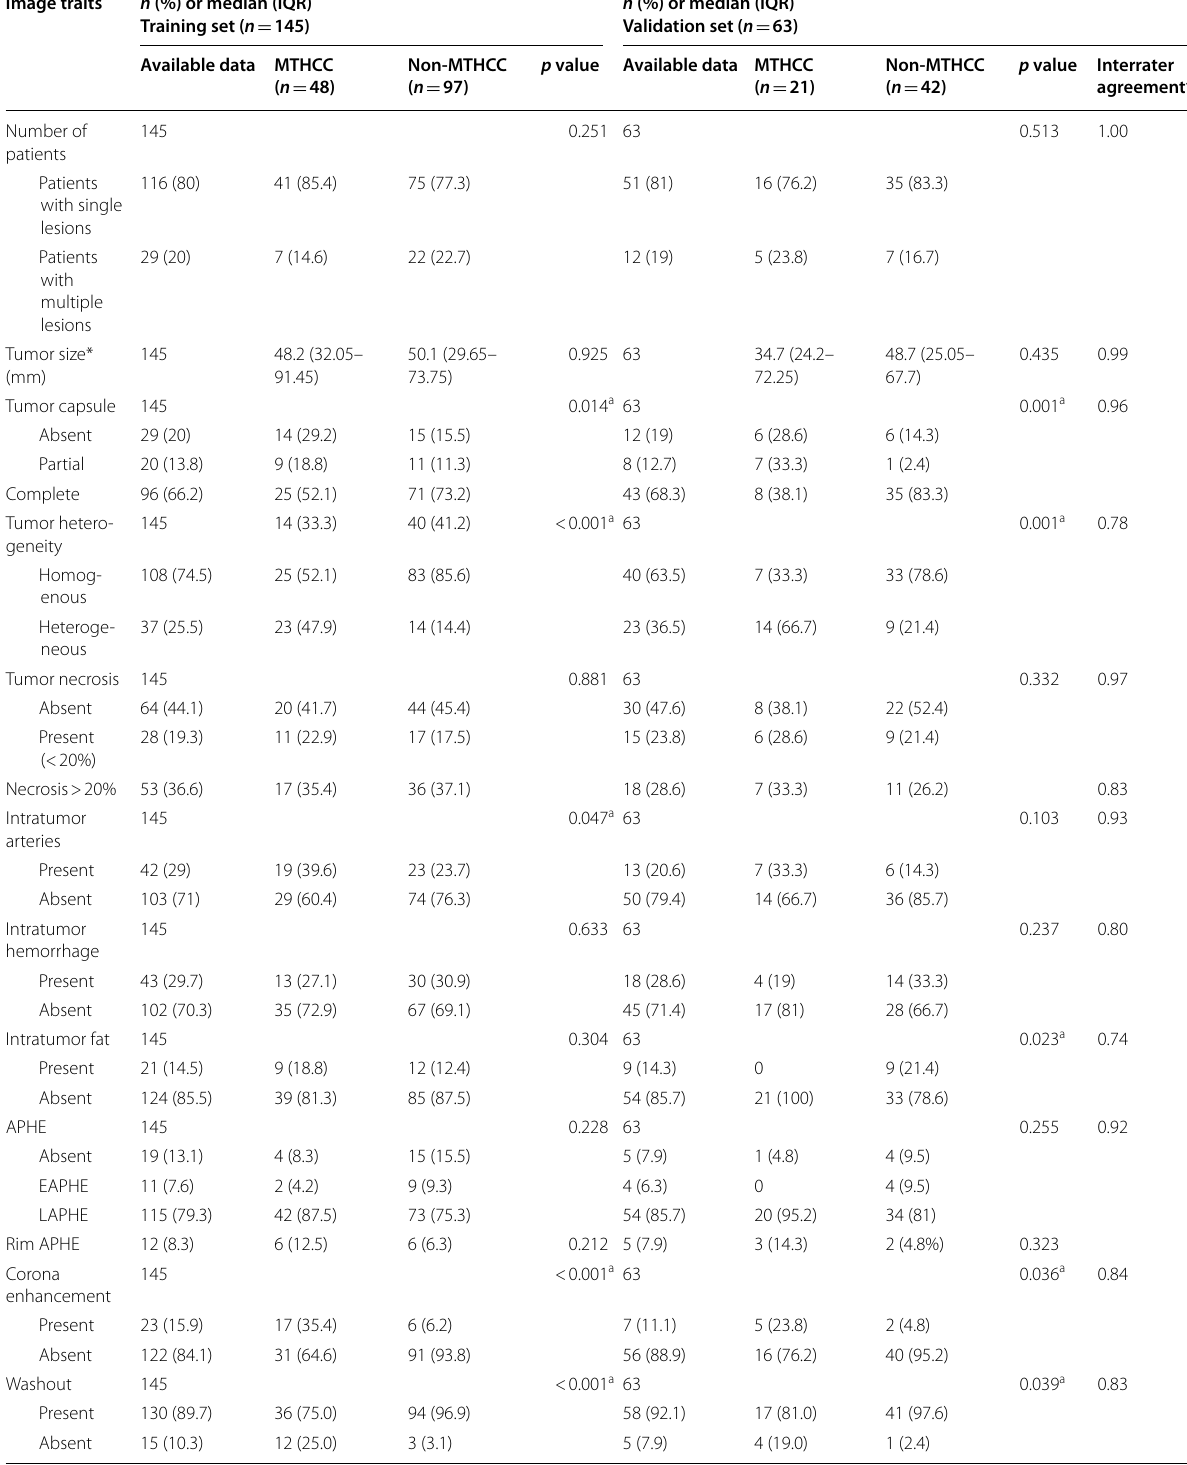
Table 3 MR imaging characteristics of the HCC lesions according to MTHCC subtype Image